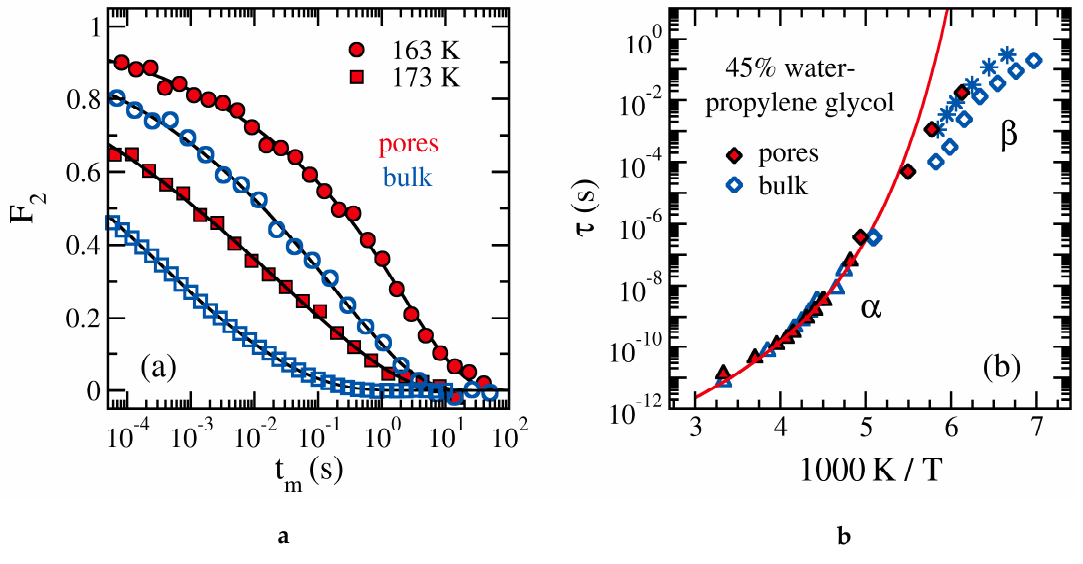
Figure 13. Results from 2 H NMR studies on 45 wt % water-propylene glycol mixture in the bulk liquid and in MCM-41 pores (diameter 2.8 nm) [217]: ( a ) Rotational correlation functions F 2 (t m ) from stimulated-echo experiments at ~163 K and ~173 K. The lines are fits to a Kohlrausch function. ( b ) Temperature-dependent correlation times from (triangles) spin-lattice relaxation, (diamonds) line-shape analysis, and (squares) stimulated-echo experiments. The line is a Vogel-Fulcher-Tammann fit of the spin-lattice relaxation results for the confined mixture, which probe its structural α relaxation. For comparison, results for the secondary β relaxation from BDS on the bulk mixture are included as stars [261] (adapted from [217]).